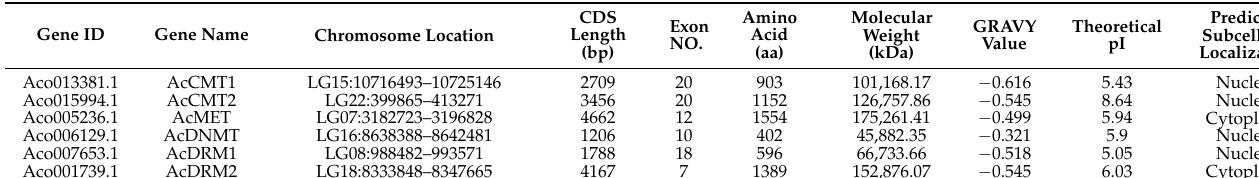
Table 2. Overview of C5-MTase genes identified in pineapple.